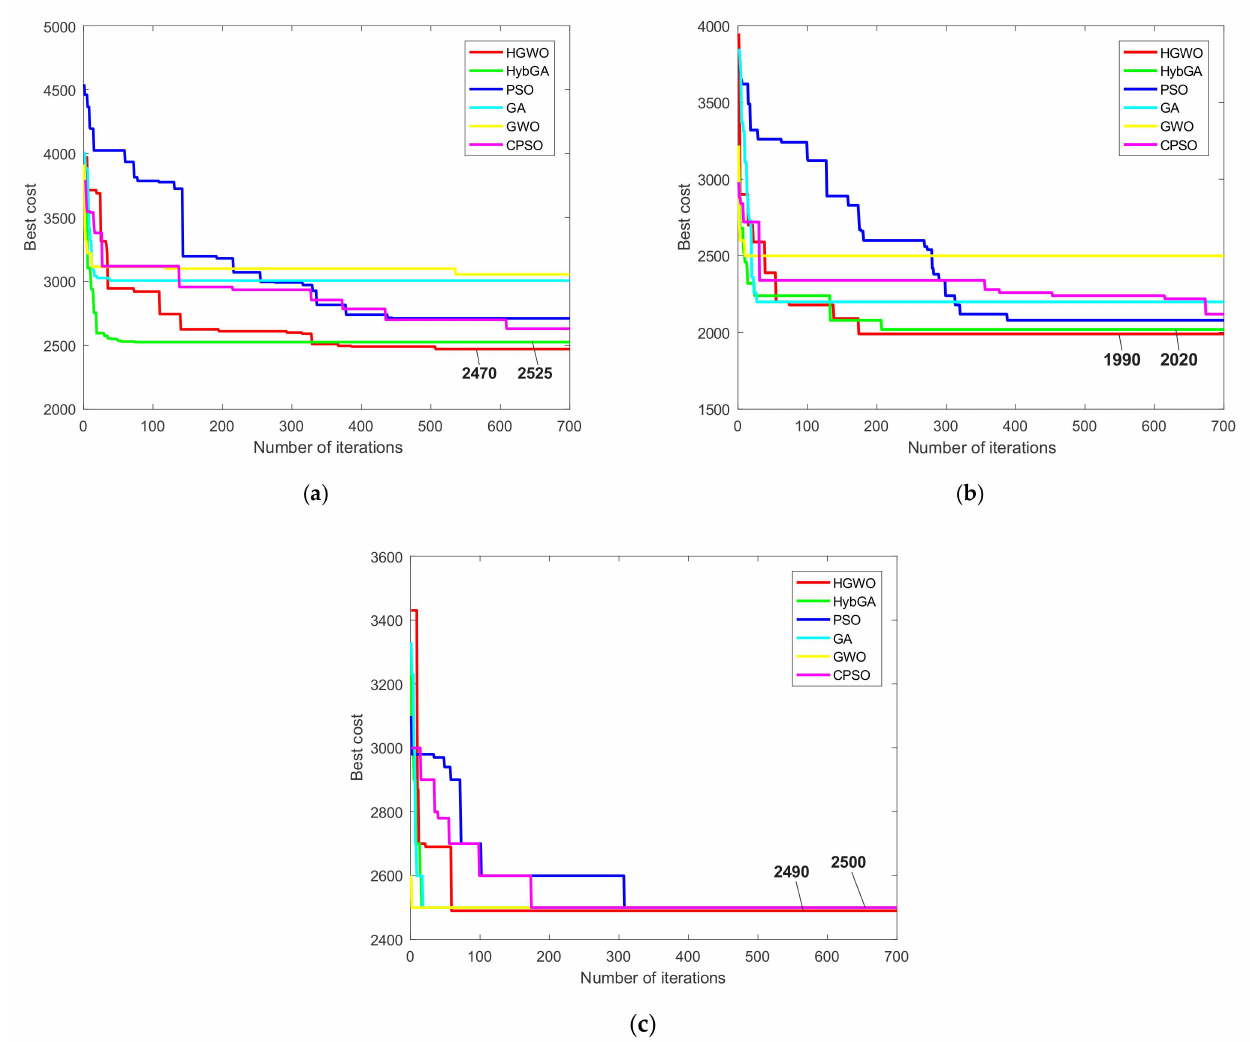
Figure 11. Convergence curves for the prismatic part 1: ( a ) 1st condition; ( b ) 2nd condition; ( c ) 3rd